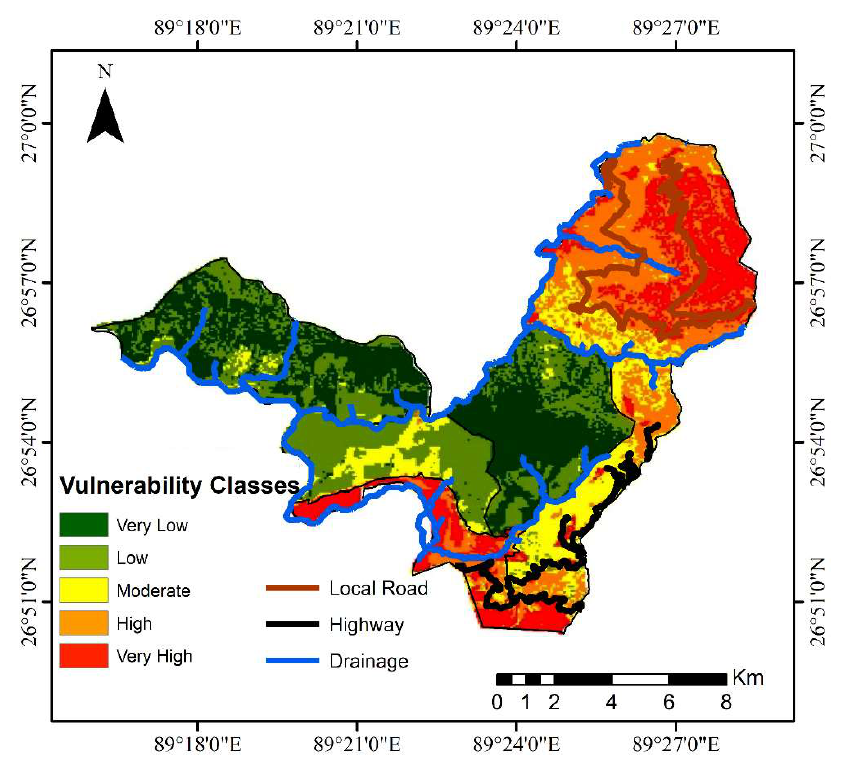
Figure 7. Landslide vulnerability map for Phuentsholing.